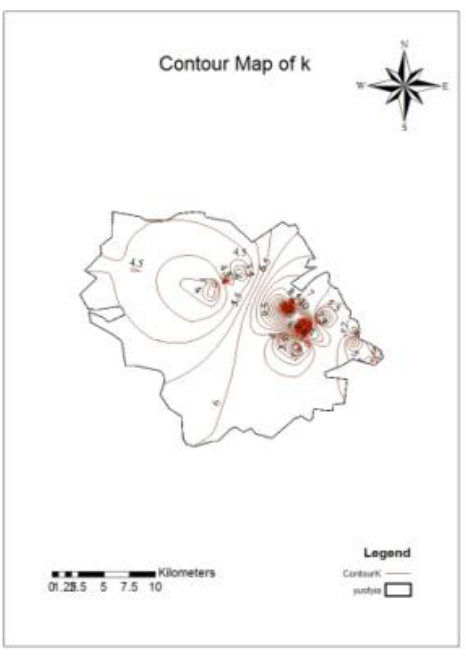
Fig.8: The interpolation and contour line of K map in ppm.